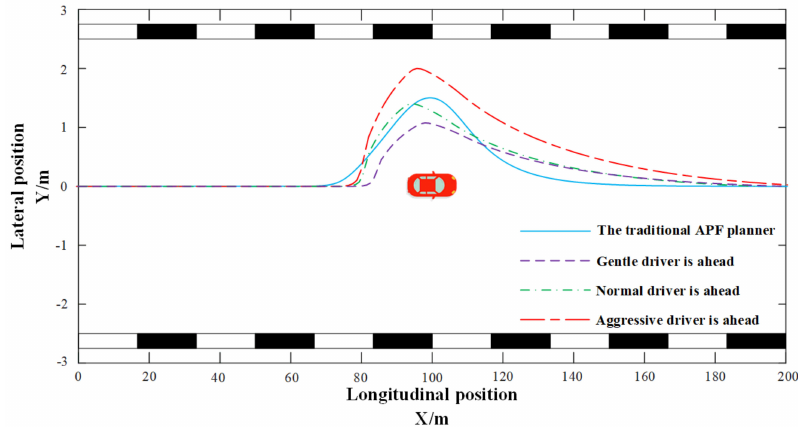
Figure 14. Path planning in overtaking scenes with different